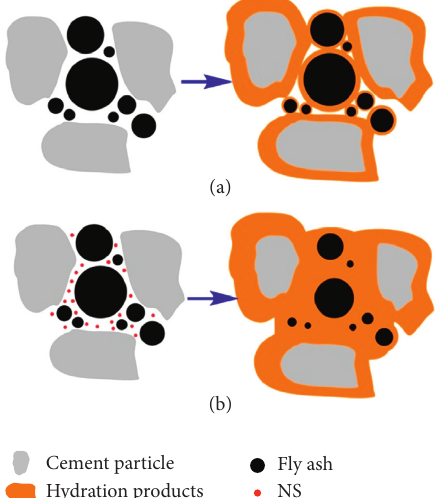
Figure 13: Mechanism behind the improvement in impermeability with NS. (a) C-FA. (b) C-FA with